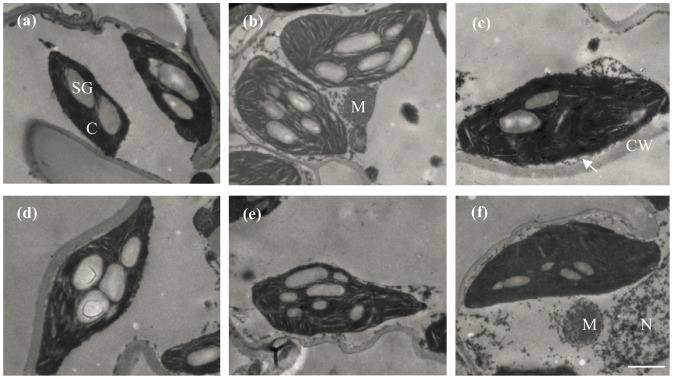
Electron micrographs of chloroplasts in newly expanded leaves of Shanyou 63 (a, low-N supply; b, intermediate.-N supply; c, high-N supply) and Yangdao 6 (d, low-N supply; e, intermediate.-N supply; f, high-N supply).Bar = 1 µm. C, chloroplasts; M, mitochondrion; N, nucleus; SG, starch granules; CW, cell wall; arrows point to plasma membrane.